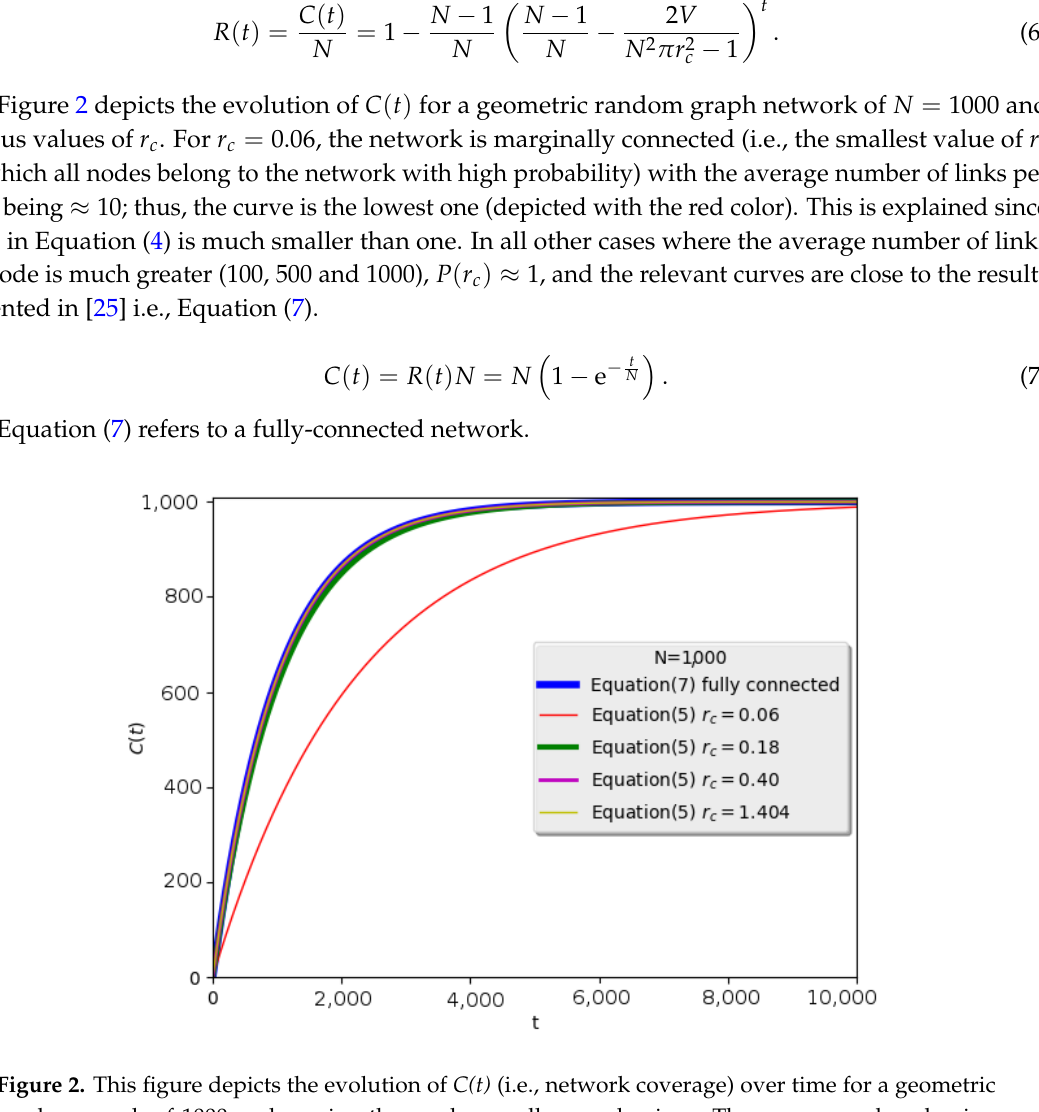
Figure 2. This figure depicts the evolution of C(t) (i.e., network coverage) over time for a geometric random graph of 1000 nodes using the random walker mechanism. The curves produced using Equation (5) (for various values of r c ) are close to the one produced using Equation (7), except from the red curve that corresponds to the smallest r c , which is where the network is marginally